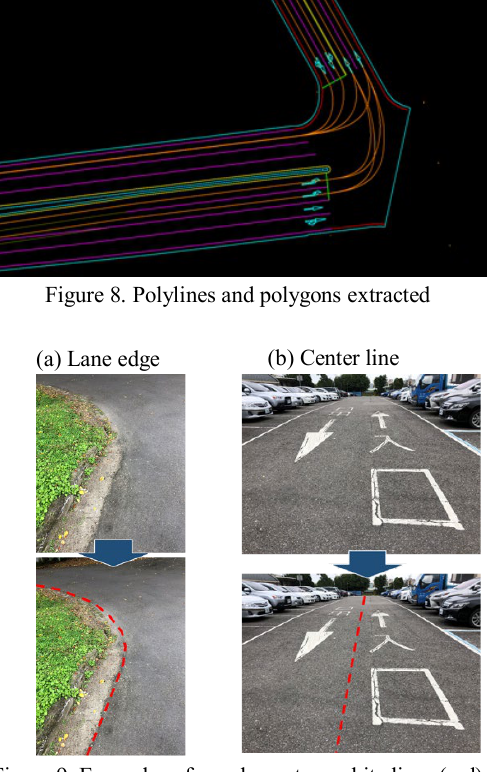
Figure 9. Examples of supplementary white lines (red)